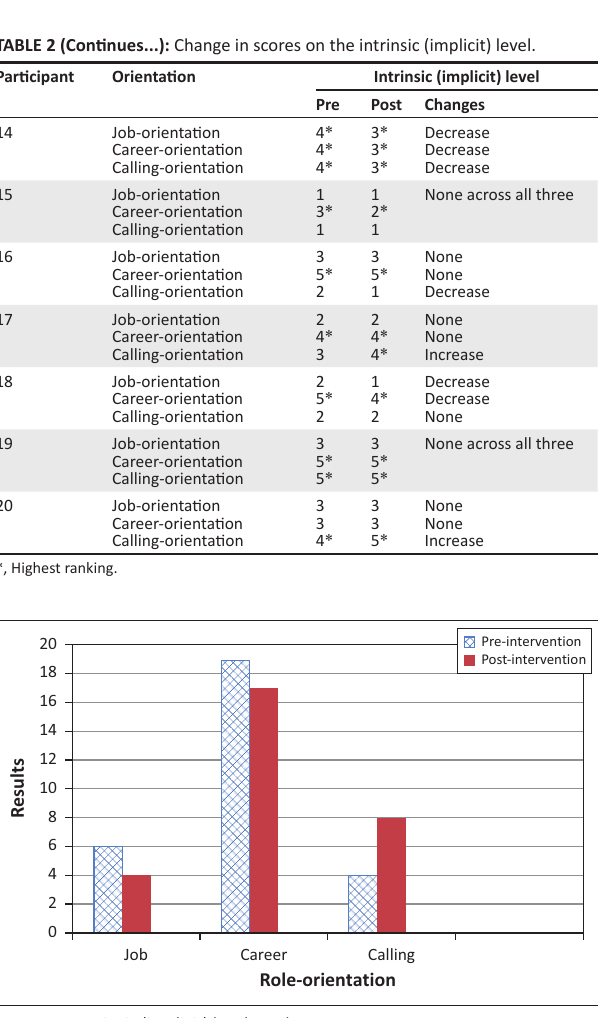
FIGURE 3: Intrinsic (implicit) level results.